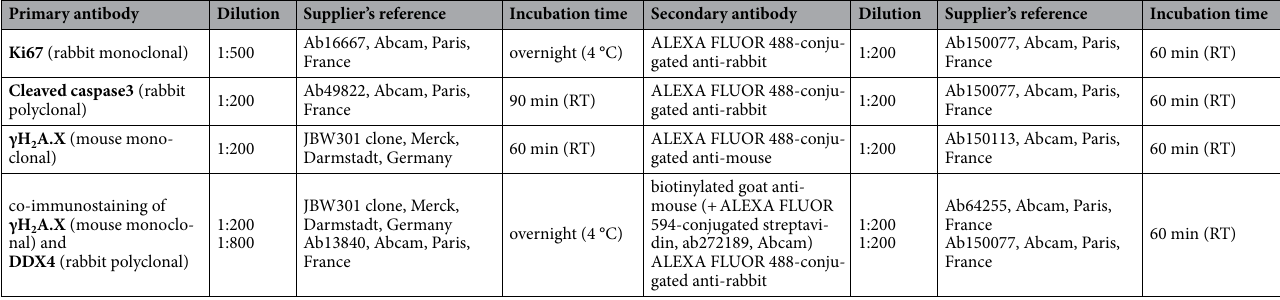
Table 1. Details of all the antibodies and conditions for immunofluorescence staining. RT: room